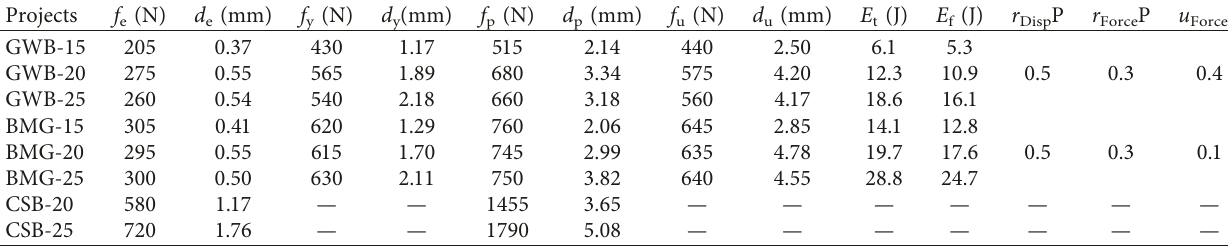
Table 1: Single-layer sheathing-to-stud connection properties [26].